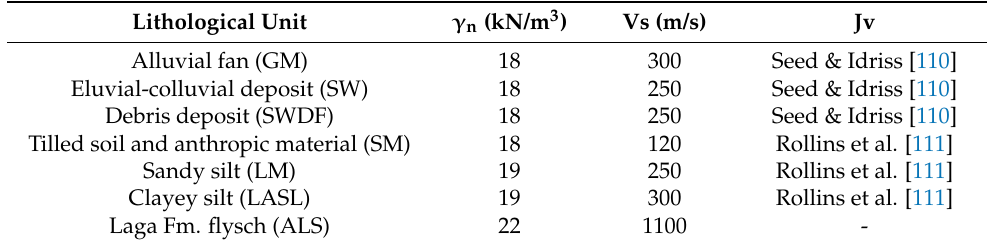
Table 2. Physical and geotechnical parameters assigned to the litotechnical units defined in the Poggio Cancelli